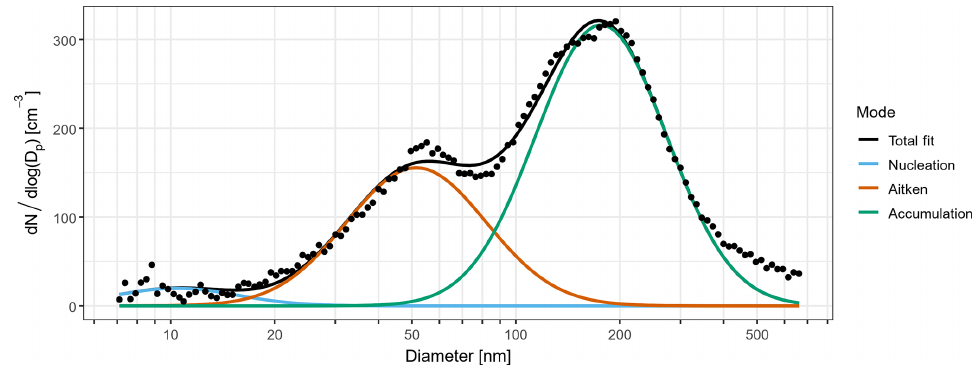
Figure 7. Mean number size distribution for sub-micron aerosol during a period likely influenced by continental and coastal Australian air masses. The coloured lines are fitted log-normal distributions representing contributions from nucleation (blue), Aitken (brown), and accumulation (green) mode aerosol to the observed total size distribution (black points).